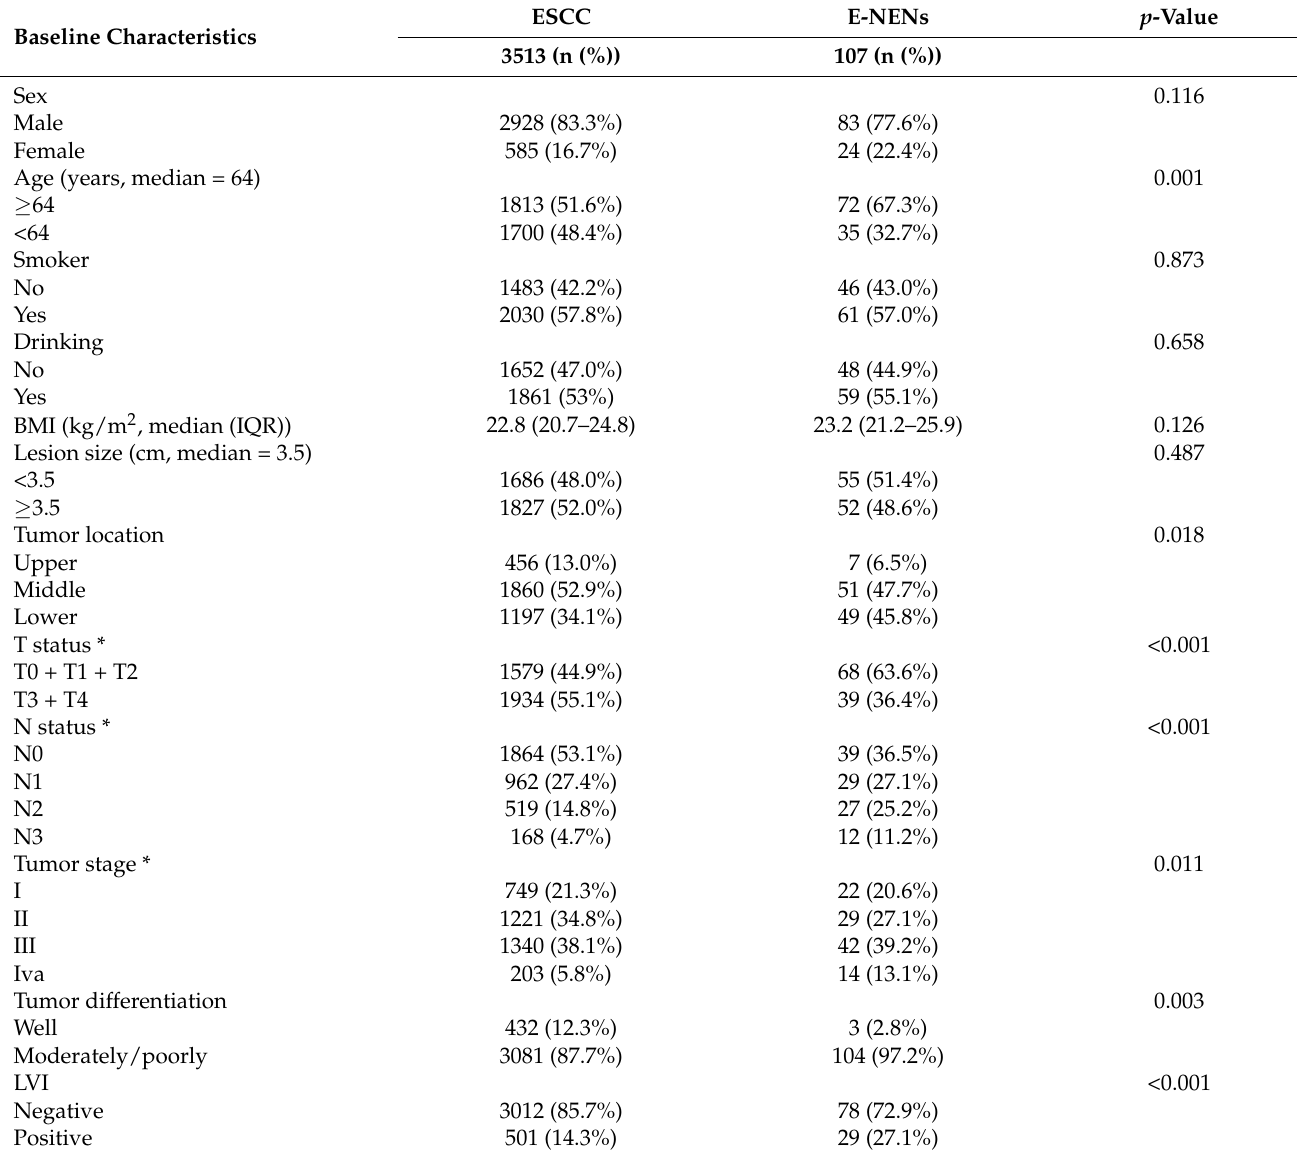
Table 1. Baseline characteristics of the enrolled population (including 3 NET